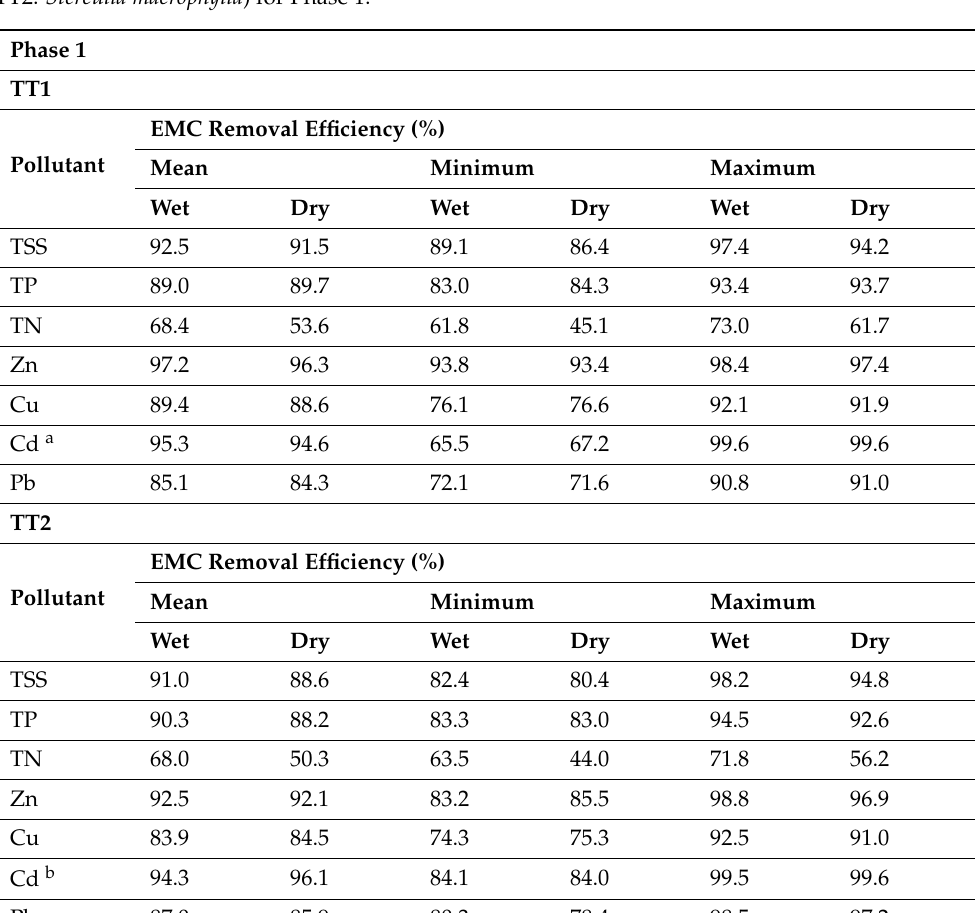
Table A4. EMC removal efficiency of pilot bioretention tree biofilter study (TT1: Talipariti tiliaceum ; TT2: Sterculia macrophylla ) for Phase